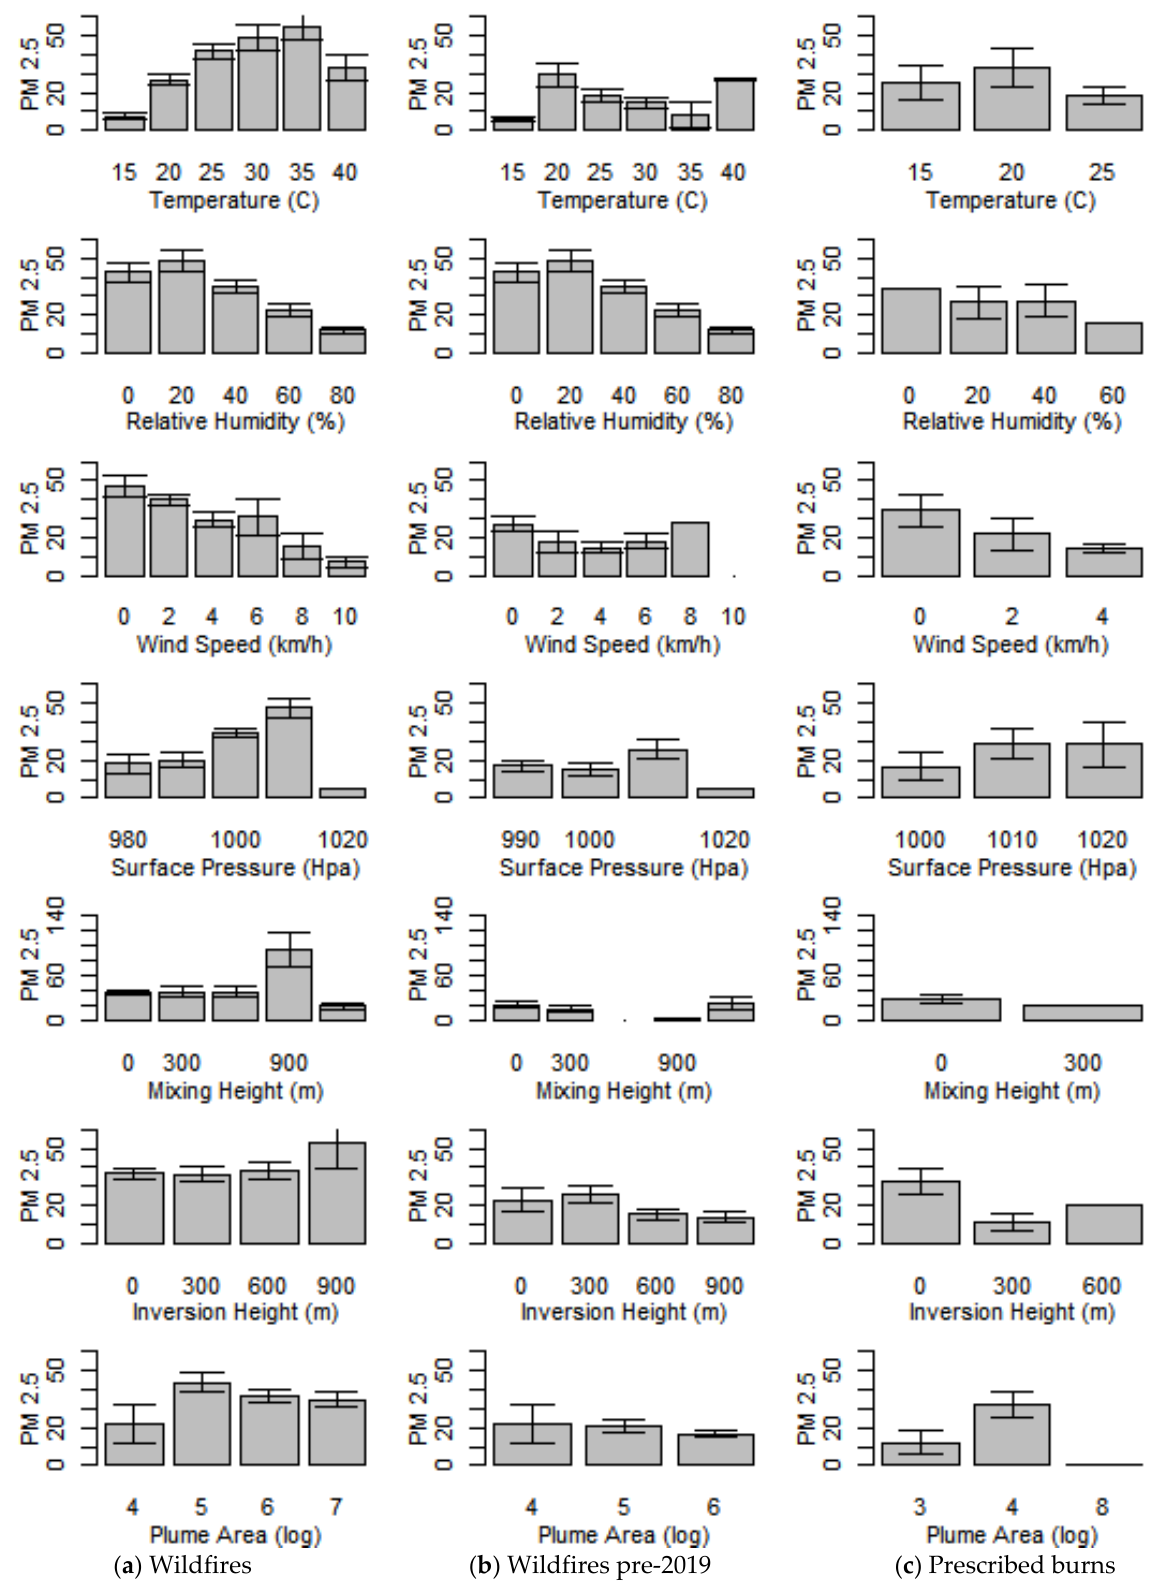
Figure 5. Relationship between daytime PM 2.5 values and predictor variables for ( a ) Wildfire plumes, ( b ) Wildfire plumes excluding the 2019-20 season, and ( c ) Prescribed burn plumes.